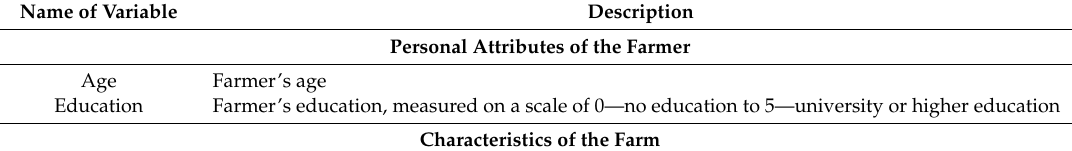
Table 1. Variables included in the